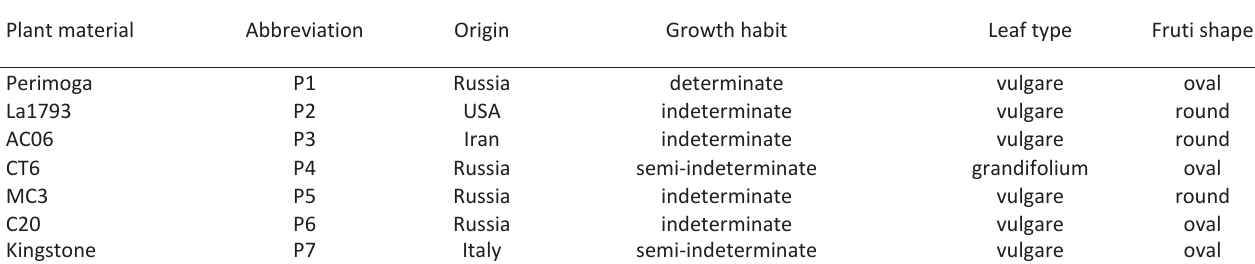
Table 1 - Description of parental inbred lines crossed in 7×7 full diallel cross system Plant